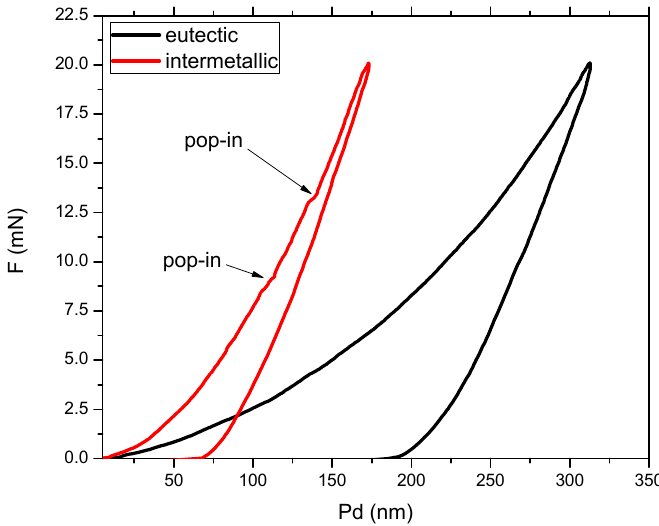
Figure 11. Instrumented indentation loading-unloading curves for the Ti 64 Zr 10 Si 15 Nb 11 bulk alloy, obtained on the softer eutectic and the harder intermetallic compound.